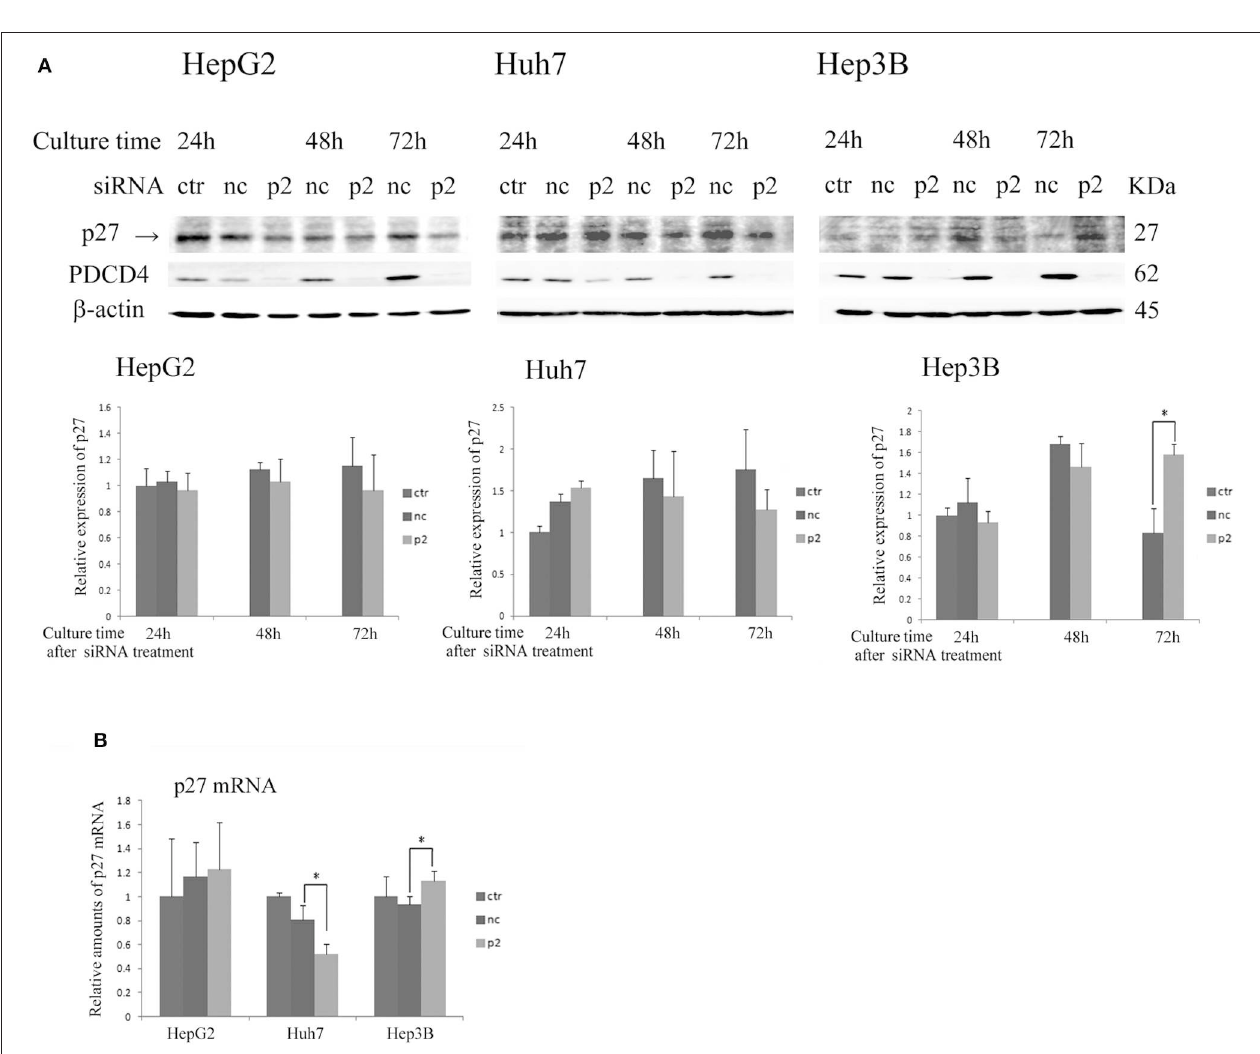
FIGURE 4 | The p27 (Cip/Kip) expression was changed only slightly or down-regulated in HepG2 and Huh7 but was up-regulated in Hep3B cells by p2 siRNA-mediated PDCD4 knockdown (A) The hepatoma cells HepG2, Huh7, and Hep3B were treated with negative control siRNA (nc) or PDCD4-specific p2 siRNA (p2) and then subjected to a Western blot analysis using p27-, PDCD4-, and β -actin-specific antibodies at the culture time indicated in the figures. ctr, control cells without siRNA treatment. The experiments were repeated at least three times, and similar results were obtained each time. The data in the diagrams represent the mean ± SD obtained from the experiments. t -test: * p < 0.05. → , the p27 band was identified by p27 knockdown using a specific siRNA. (B) A real time RT-PCR analysis of p27 in PDCD4 knockdown HepG2, Huh7, and Hep3B cells. The cells were treated with negative control siRNA (nc) or PDCD4-specific p2 siRNA (p2) and cultured for 48h. The experiments were repeated independently 3 times. Data were expressed as the mean ± SD obtained from the experiments. t -test: * p < 0.05. The p16 band was not detected in p16-deficient Huh7 cells observed with both p2 and k603 siRNA treatments at least until (33). The p18 expression was little changed at both protein and 72 h culture ( Figures 5A,B and Figure S4B ) compared to the negative control siRNA treatments in HepG2 and Hep3B cells. mRNA levels in HepG2, Huh7, and Hep3B cells under PDCD4